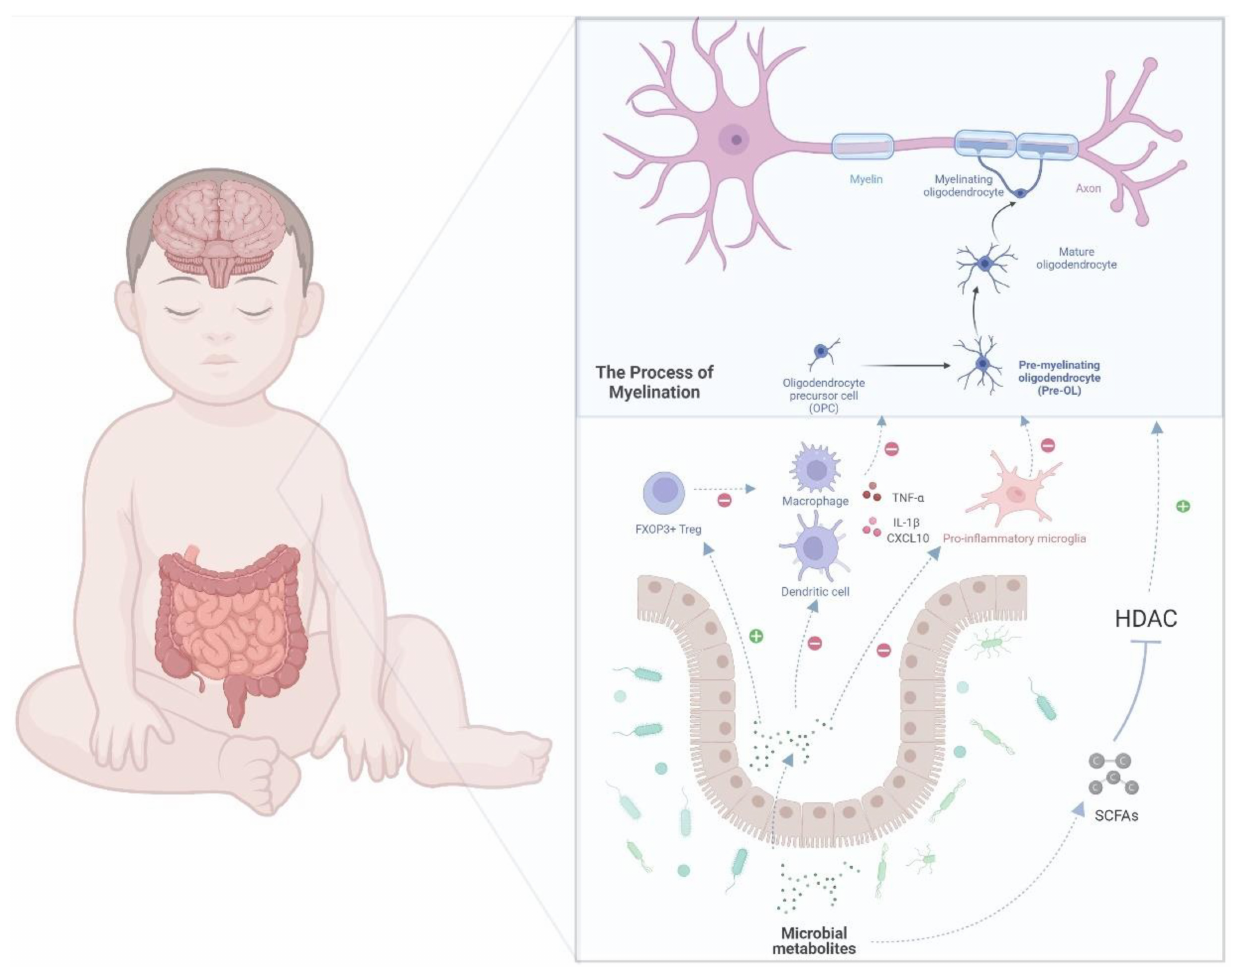
FIGURE 2 | A potential gut–brain pathway through which the microbial metabolites might modulate preterm white matter injury. Myelination, which is determined by the normal maturation of pre-OLs, plays a key role in WMI. In the gut–brain axis, the microbial metabolites, such as SCFAs, which inhibit HDAC, could regulate oligodendrocyte maturation and subsequently myelination. Moreover, SCFAs can also regulate immune cells, such as macrophages, T cells, microglia, and DCs. For example, SCFAs could inhibit the differentiation of microglia into pro-inflammatory type, which may damage the maturation of pre-myelinating oligodendrocyte. In addition, SCFAs could weaken the production of cytokines, such as interleukin-1 β and CXCL10. By modulating the immune cells and cytokines, microbial metabolites can further regulate oligodendrocyte maturation and protect extremely preterm infants from WMI. DCs, dendritic cells; IL-1 β , interleukin-1;